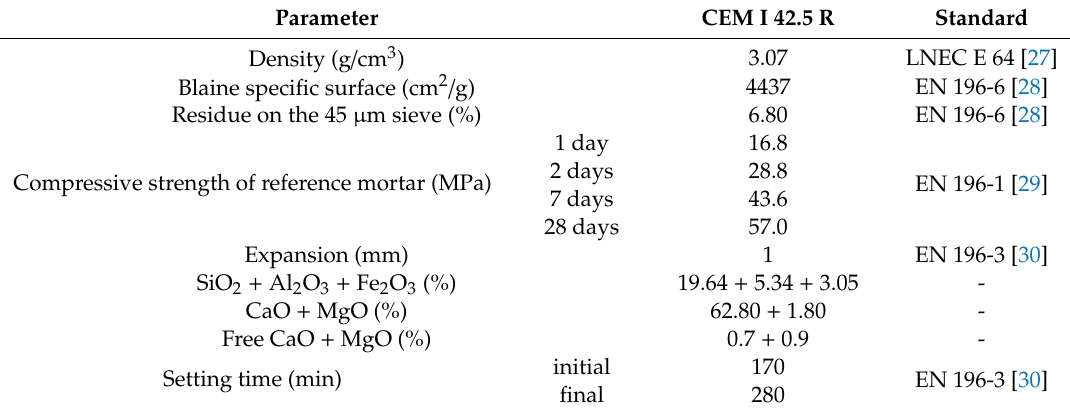
Table 1. Properties of the ordinary PC (provided by the supplier